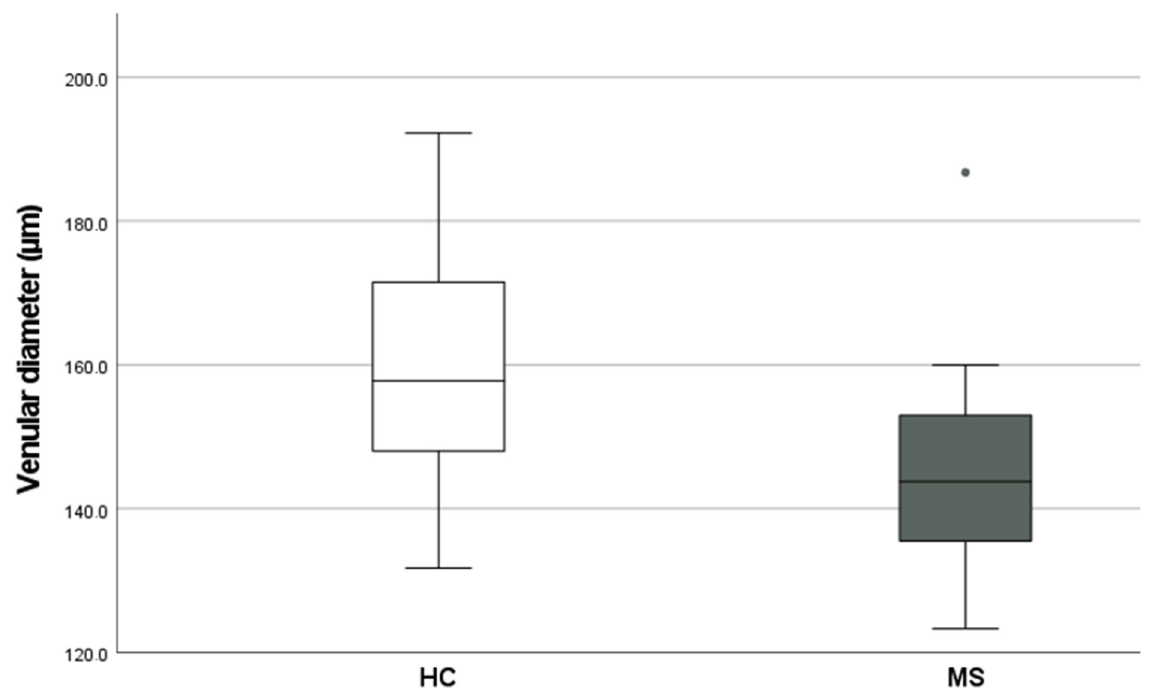
Figure 1. Distribution of retinal venular diameter between the healthy controls (HC) and patients with MS groups. Data presented are in the form of median (IQR: Interquartile range). HC: Healthy Controls; MS: Multiple sclerosis, p < 0.05.